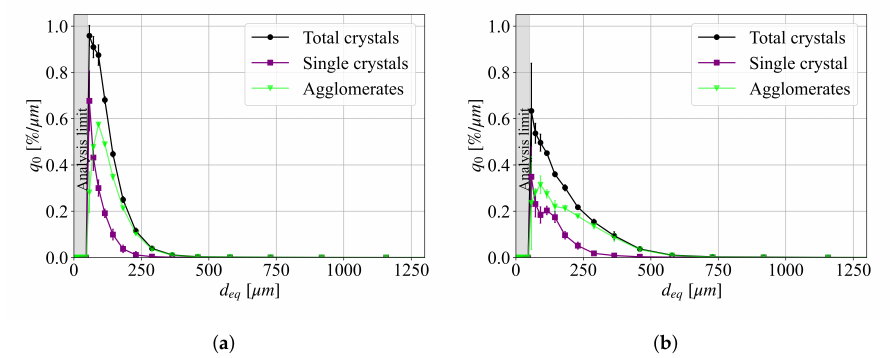
Figure 9. PSD including total crystals (black) and subpopulations of single crystals (green) and agglomerates (magenta) after crystallization for ϑ sat = 40 ◦ C on the left ( a ) and ϑ sat = 50 ◦ C on the right ( b ). The error bars are calculated according to the three replicated crystallizations for each saturation